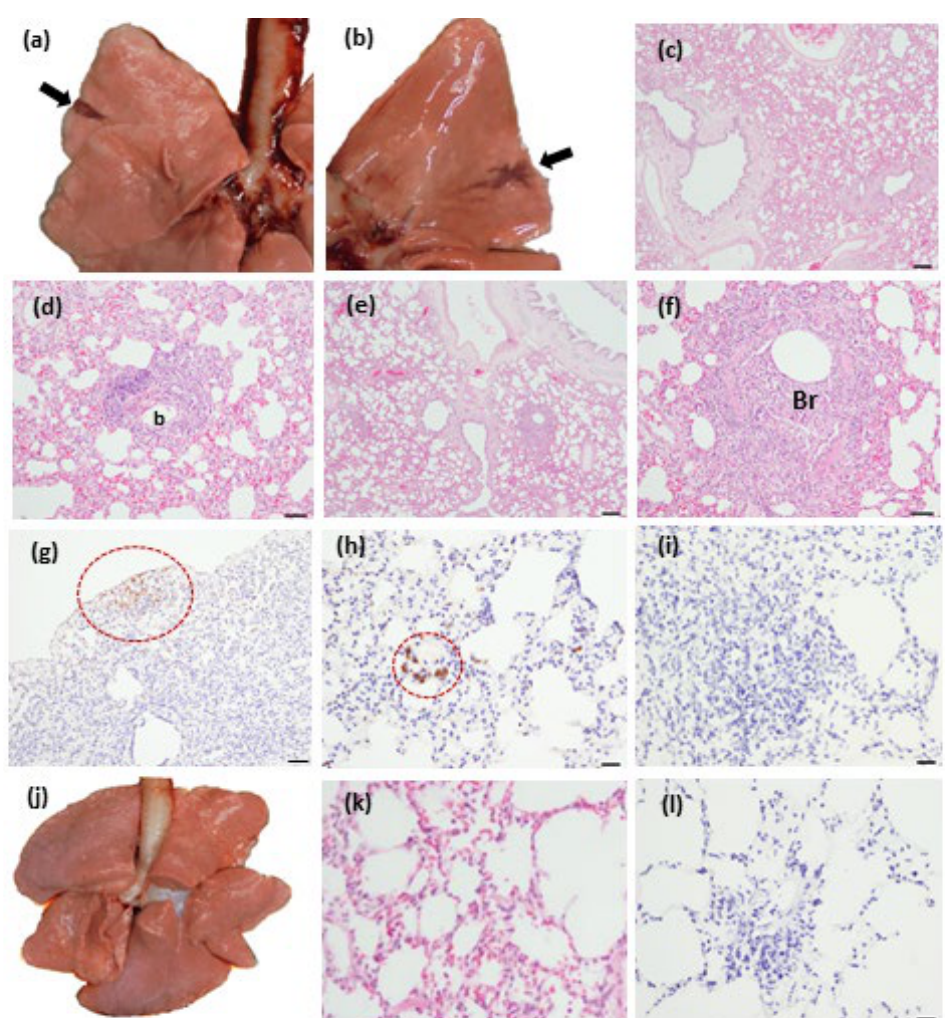
Figure 2. Pathologic changes in the lungs of dogs inoculated with SARS-CoV-2 or MERS-CoV. Pulmonary consolidation (arrowhead) in the right dorsal lobe of a SARS-CoV-2-infected dog ( a ) and in the left dorsal lobe of another SARS-CoV-2-infected dog ( b ). Mild interstitial pneumonia (( c ); × 40, hematoxylin and eosin stained) and perivascular infiltration of lymphocytes, macrophages, and degenerate neutrophils (( d ); 273 × 200, (b): blood vessel) in a SARS-CoV-2-infected dog. Mild interstitial pneumonia was observed in a MERS-CoV-infected dog (( e ); × 40). Focal bronchiolitis (Br) with perivascular infiltration of lymphocytes, macrophages, and degenerate neutrophils was detected (( f ); × 200). SARS-CoV-2 antigen detection by immunohistochemistry (IHC) in alveolar macrophages and neutrophils in the red circles (( g ); × 100, bar: 50 µ m) (( h ); × 200; bar: 20 µ m) in the lung tissue of a SARS-CoV-2-infected dog. The MERS-CoV antigen was not detected by IHC (( i ); × 100; bar: 50 µ m). Lung ( j ) and histology (( k ); × 200; hematoxylin-and-eosin stained; bar: 20 µ m, ( l ); × 200, IHC; bar: 20 µ m) of the negative control dog. S; SARS-CoV-2-infected dogs, M; MERS-CoV-infected dogs, C; negative control